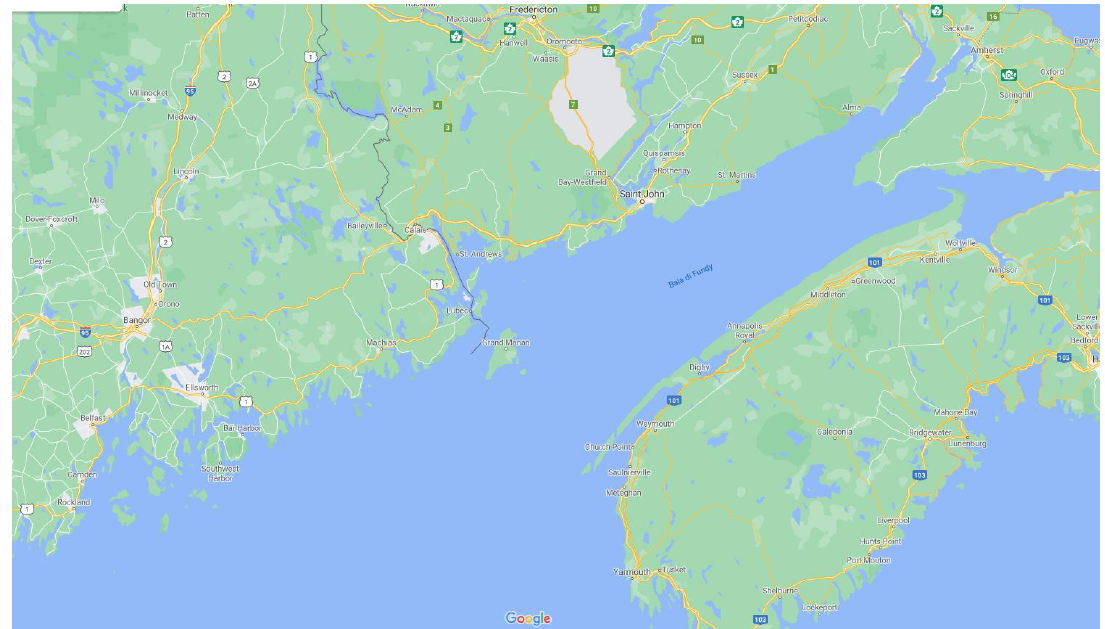
Figure 5. Example of bays in North America.